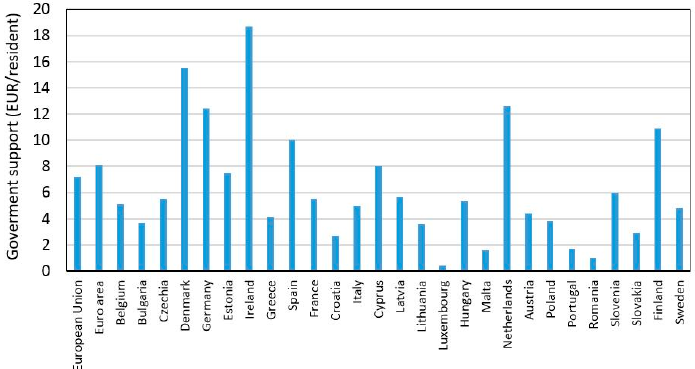
Figure 28. Governmental financial support for agricultural research and development in the member states of the EU, 2020, data from Eurostat [70].